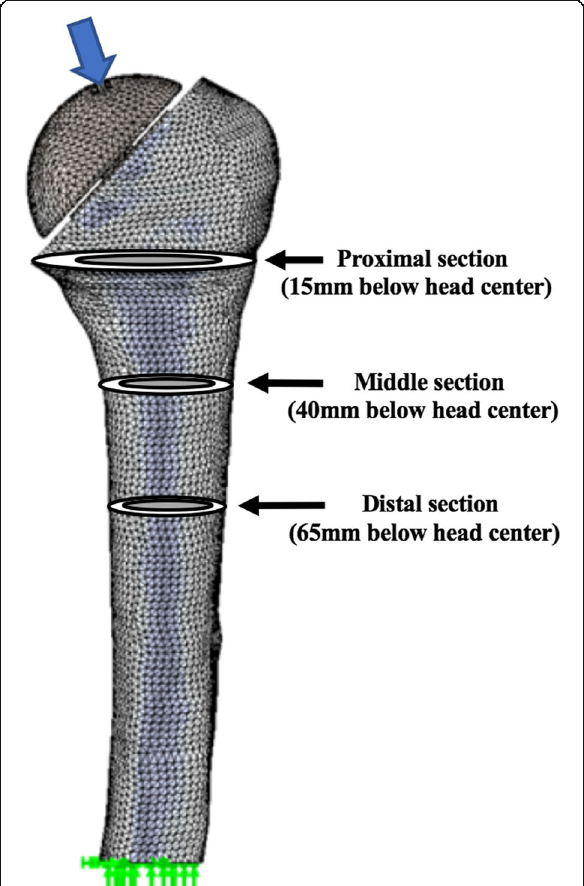
Fig. 3 Meshed model of an implanted humerus, rigidly fixed at the distal part, indicating the direction of the proximal load towards the center of the prosthetic